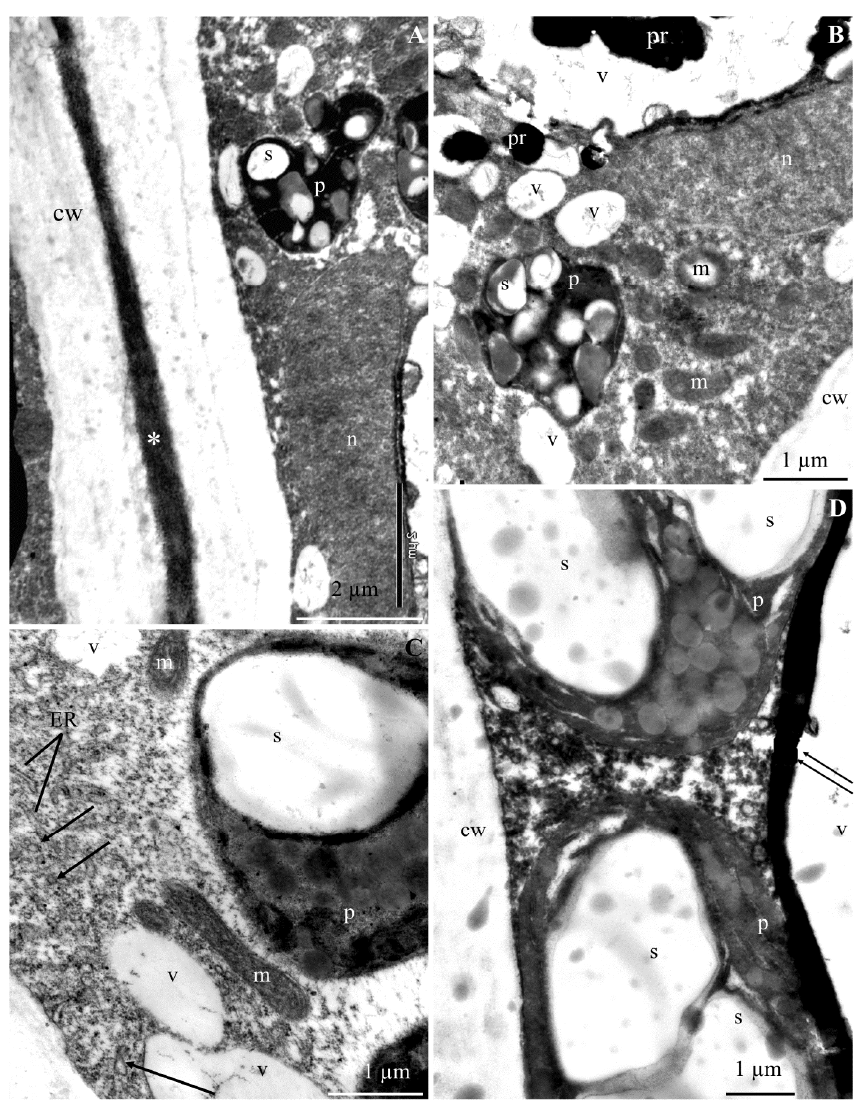
Figure 7. Fragments of the cross sections of hypodermis cells from the apical part of ‘Szampion’ apples from the EDTA-chelated Ca foliar feeding treatments A : cell wall (cw), visible middle lamella (asterisk), lobular cell nucleus (n), plastids (p) with starch grains (s). B , C : parietal cytoplasm, visible mitochondria (m), plastids with starch grains (s), large vacuole (v) or several small vacuoles, endoplasmic reticulum (ER) (Figure 7C); D : thick and intensely stained tonoplast (two arrows), visible cell wall (cw), plastids (p) with starch grains (s), vacuole (v).